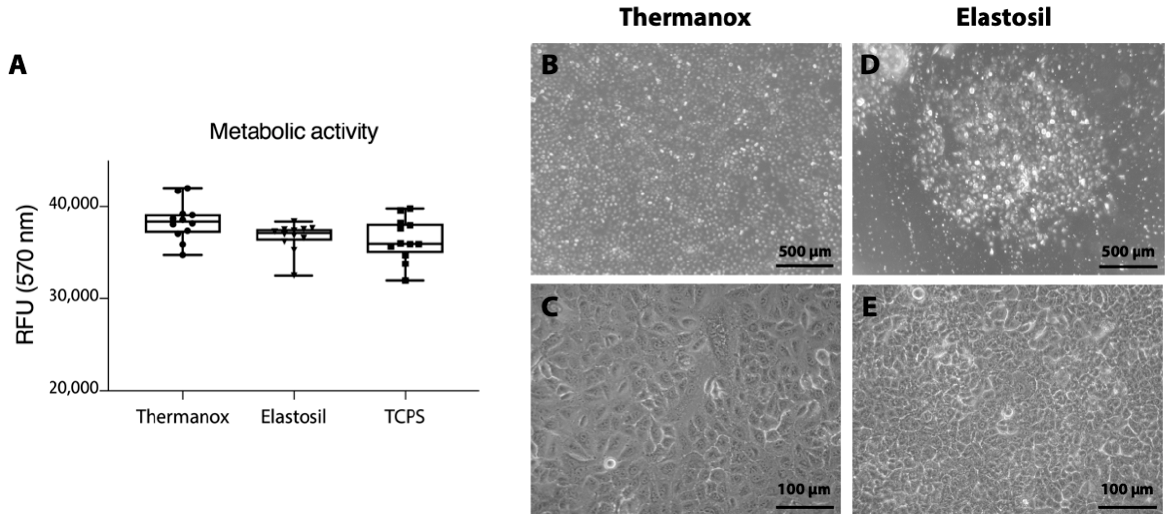
Figure 2. ( A ) Cell metabolic activity (resazurin assay, RFU: relative fluorescence units) of A549 cultured on Thermanox™ Coverslips and on Elastosil ® Film (there were no statistical differences between samples, TCPS was used as standard control, n = 12). ( B – E ) Phase-contrast images of A549 cells cultured on Thermanox™ Coverslips ( B , magnification 5×; C , magnification 20× or Elas- tosil ® Film ( D , magnification 5×; E , magnification 20×.